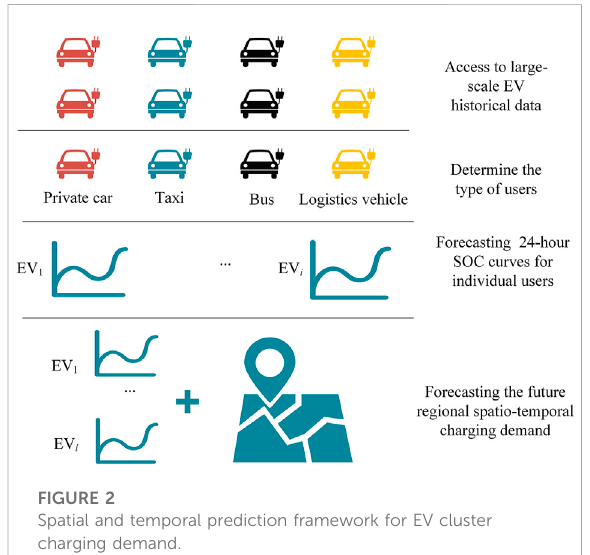
FIGURE 2 Spatial and temporal prediction framework for EV cluster charging